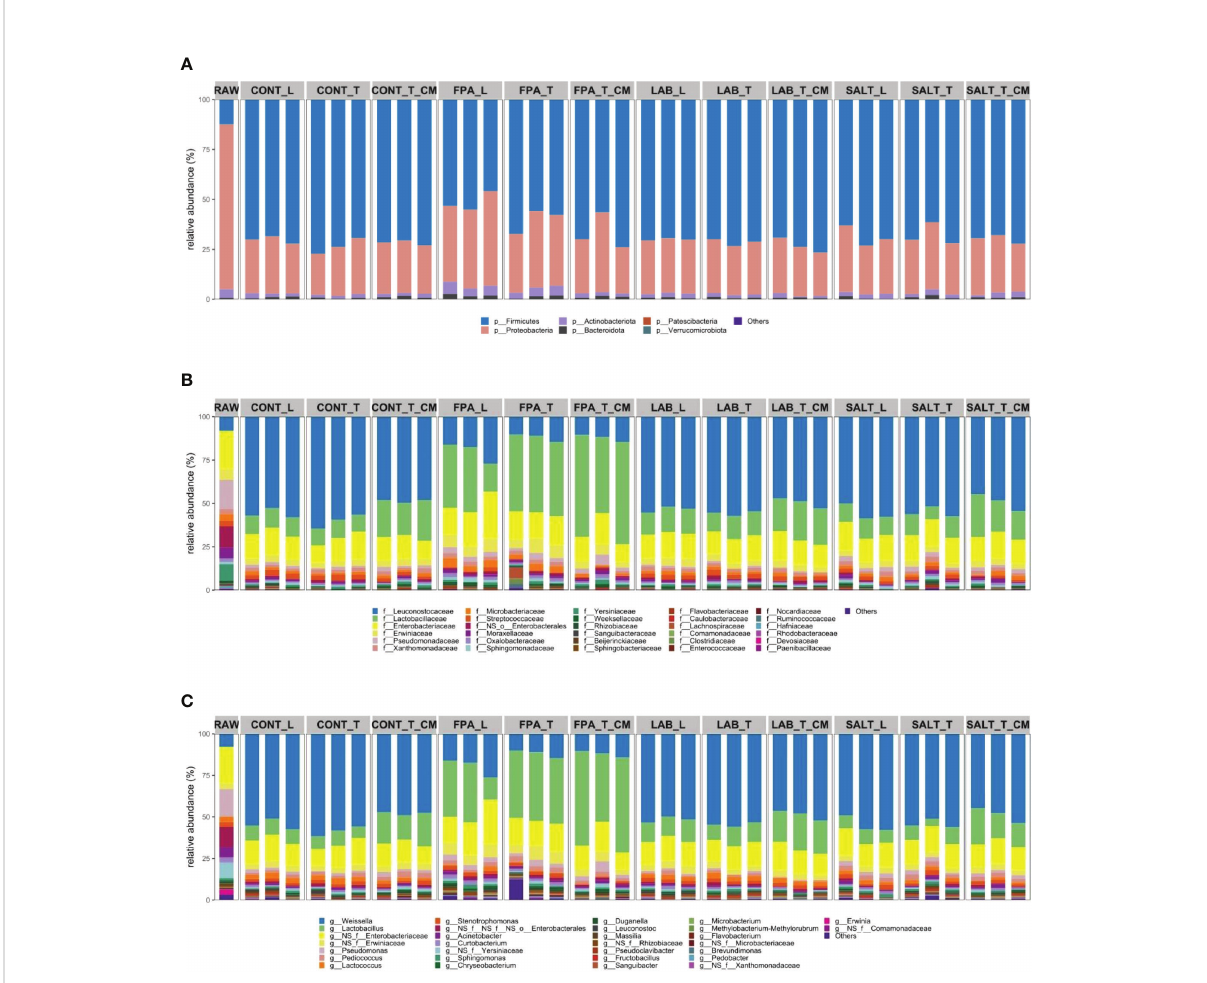
FIGURE 2 Relative abundance of bacterial communities at phylum (A) , family (B) and genus (C) taxonomic levels of red clover dominated silages treated with additives under different compaction and soil contamination levels. RAW: raw material prior ensiling; CONT, Control; FPA, Formic and propionic acid-based additive; LAB, Lactic acid bacteria inoculant; SALT, Salt-based additive; L, loosely compacted silages; T, tightly compacted silages; CM, tightly compacted and contaminated